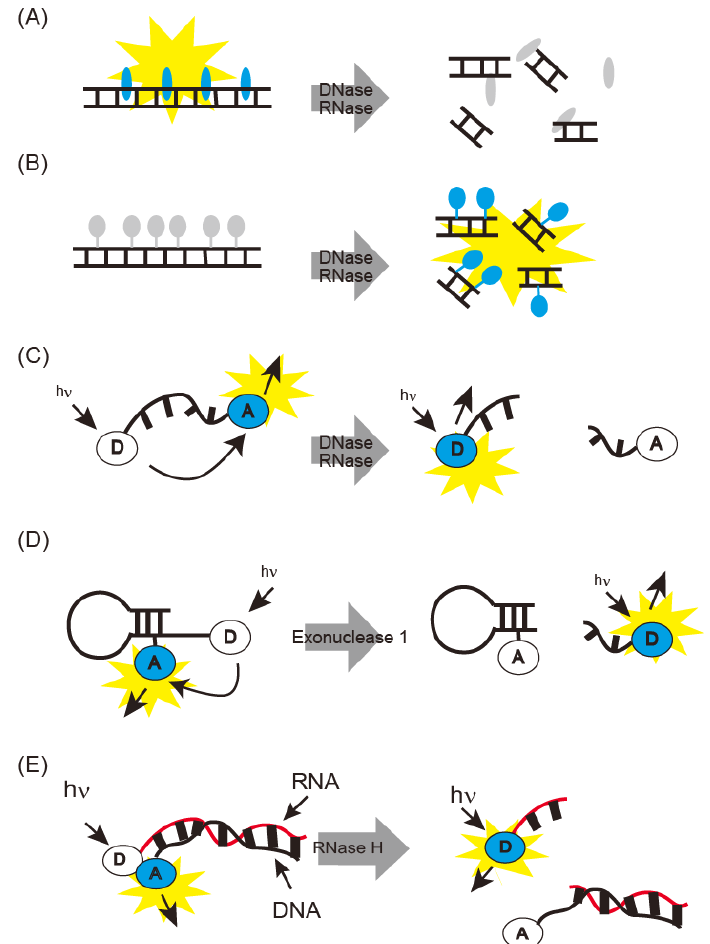
Figure 1. Fluorometric nuclease detection methods: ( A ) fluorescence intensity of non-covalent DNA-binding ligand; ( B ) recovery of self-quenched covalent fluorescent dye-DNA conjugate; ( C ) dequenching of FRET probes; ( D ) dequenching of hairpin-type FRET probes partially modified by phosphorothioate; and ( E ) de-hybridization of duplexes carrying FRET dyes after digestion with DNase, RNase, Exonuclease 1, or RNase